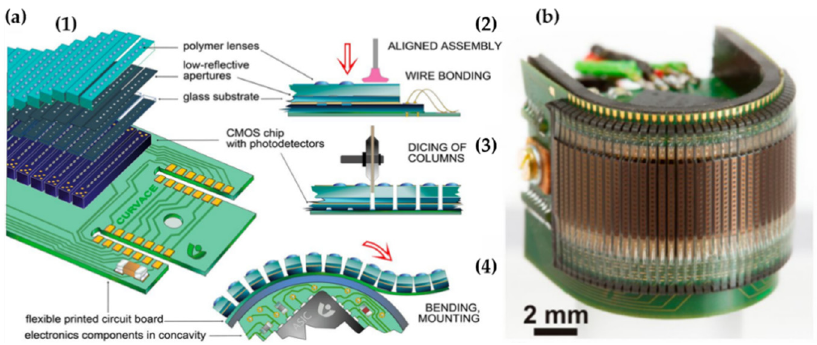
Figure 17 . ( a ) The curved design and assembly. ( b ) The picture of the curved prototype. Reprinted from [56] CC by 4.0. Table 4. The parameters and performance of the artificial compound eye imaging system with curved microlens array integrated to a curved image